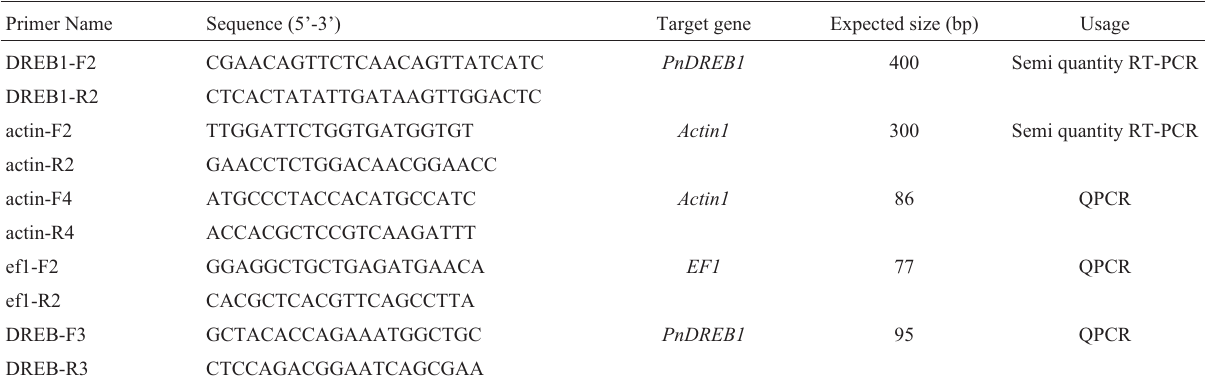
Table 1 - Primer sequences for expression level